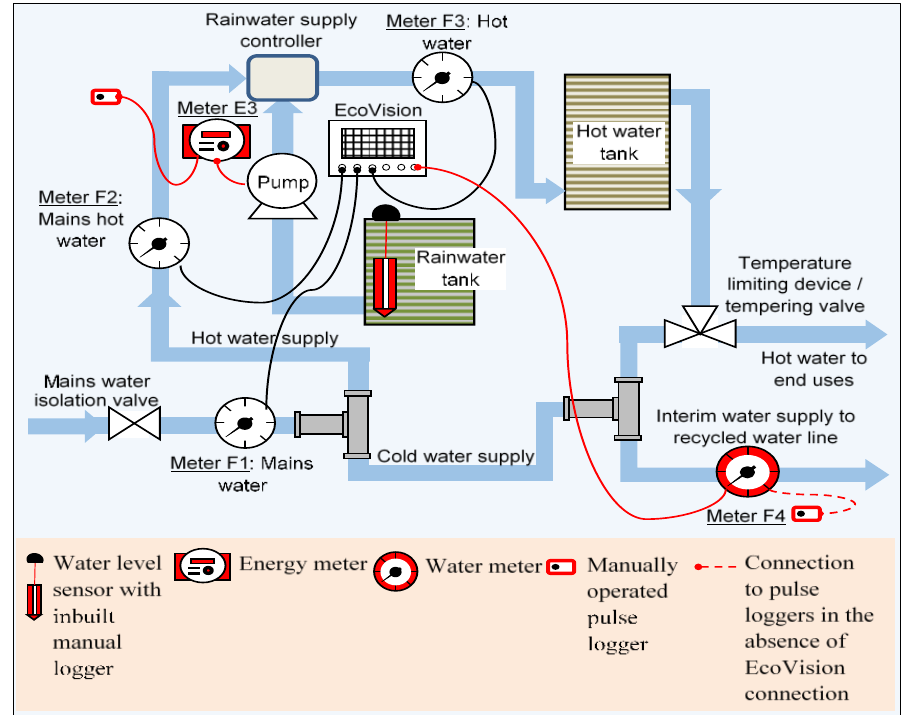
Figure 2. Diagram of final water monitoring setup in a typical Lochiel Park residence installed specifically for this research. Table 1. Roof runo ff harvesting (RR system